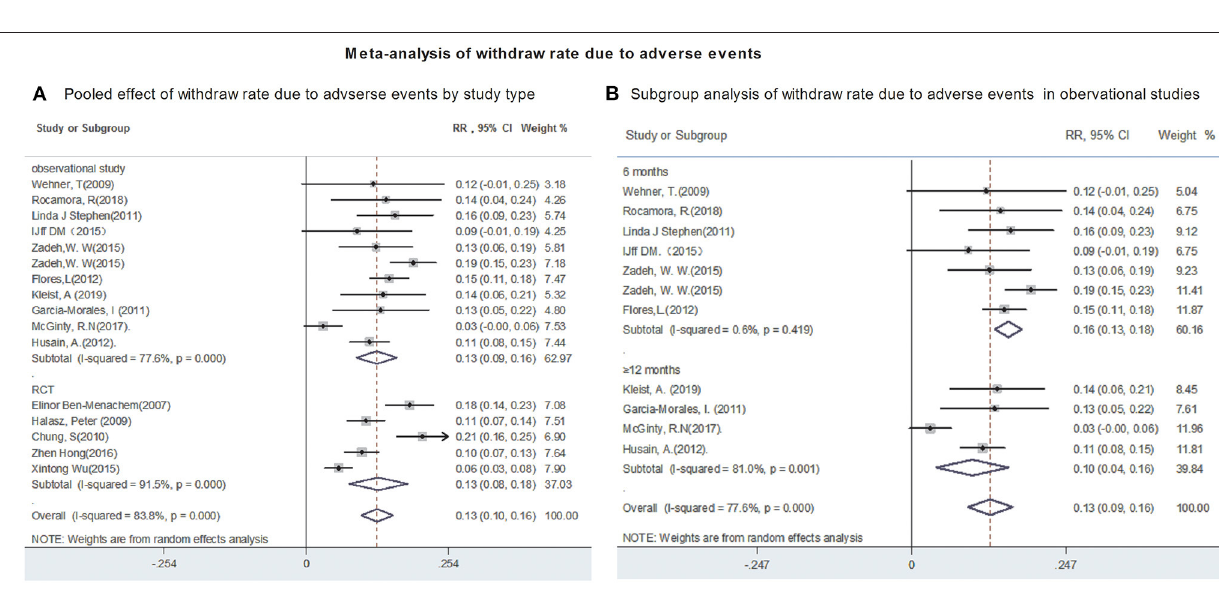
freedom in real-world studies. Further, seizure freedom for a long period of time (patients treated with LCM ≥ 12 months) was similar to that of 6–month of LCM adjunction. Altogether, these results suggested that the efficacy outcomes of LCM adjunction for real-world studies were similar or even better than that of randomized controlled, forced titration trials. In agreement with our findings, Villanueva et al. investigated a large series of patients with partial-onset seizures treated with LCM as early add-on therapy in clinical practice and revealed a